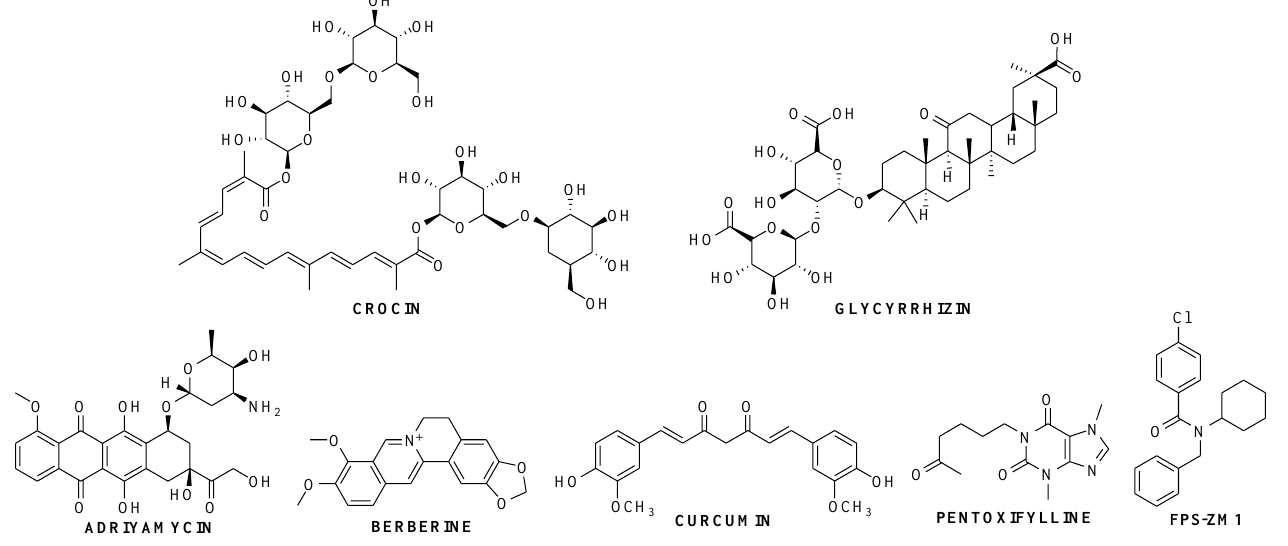
Figure 3. Molecules useful for the treatment of neuro-degenerative disorders acting through the HMGB1/RAGE axis.